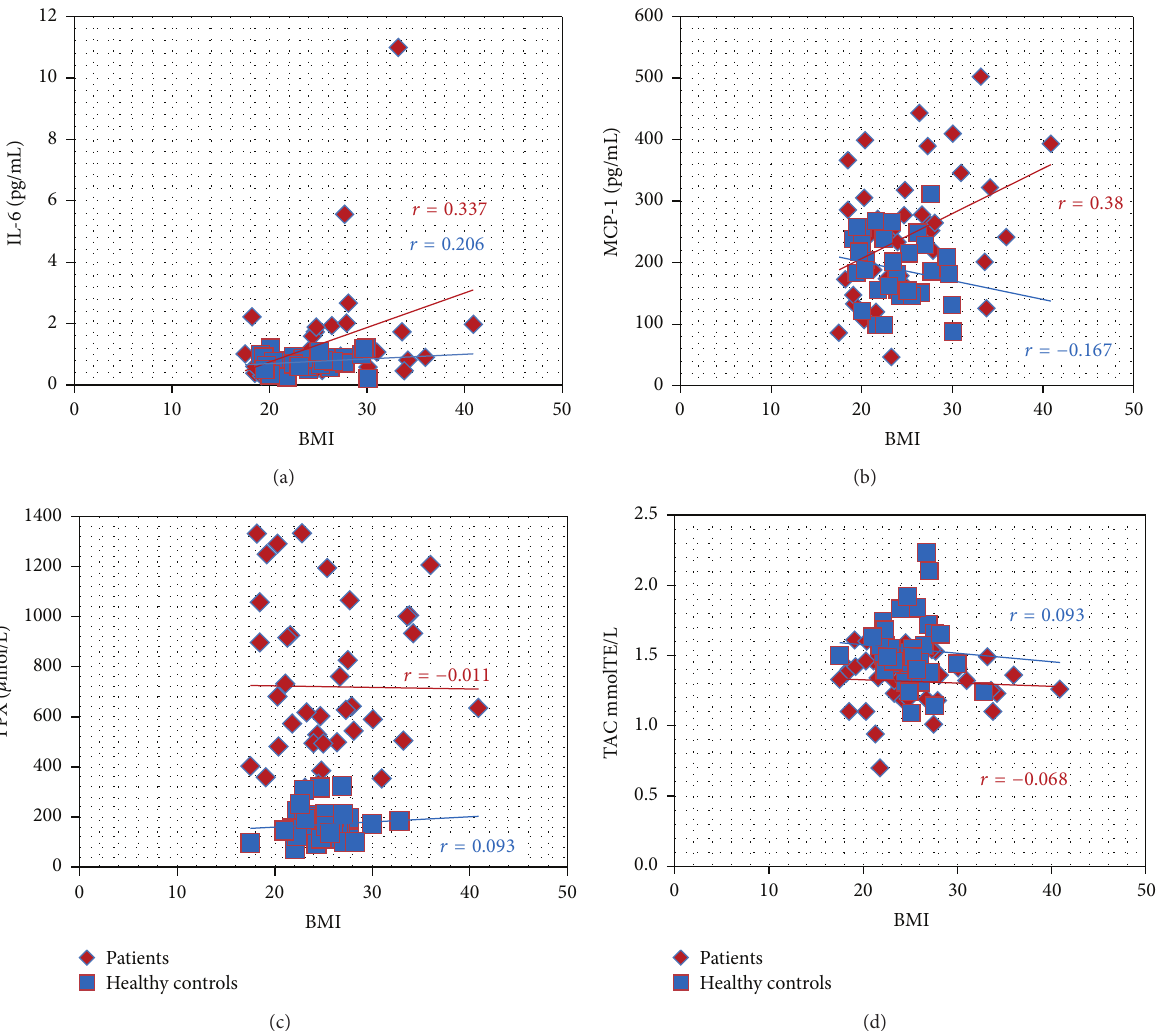
Figure 2: Scatterplot of correlation analysis of IL-6, MCP-1, TPX, and TAC with BMI in patients with allergic contact dermatitis and healthy controls. IL: interleukin; MCP: monocyte chemoattractant protein; TPX: total peroxide concentration; TAC: total antioxidant capacity; TE: Trolox equivalent; BMI: body mass